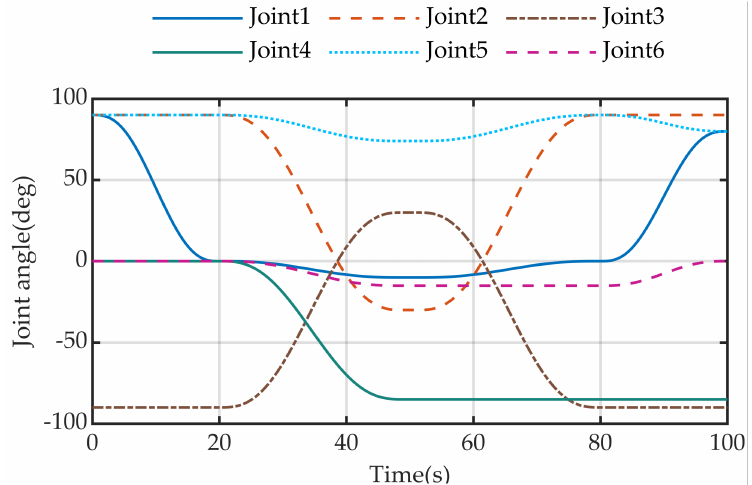
Figure 4. Planned joint